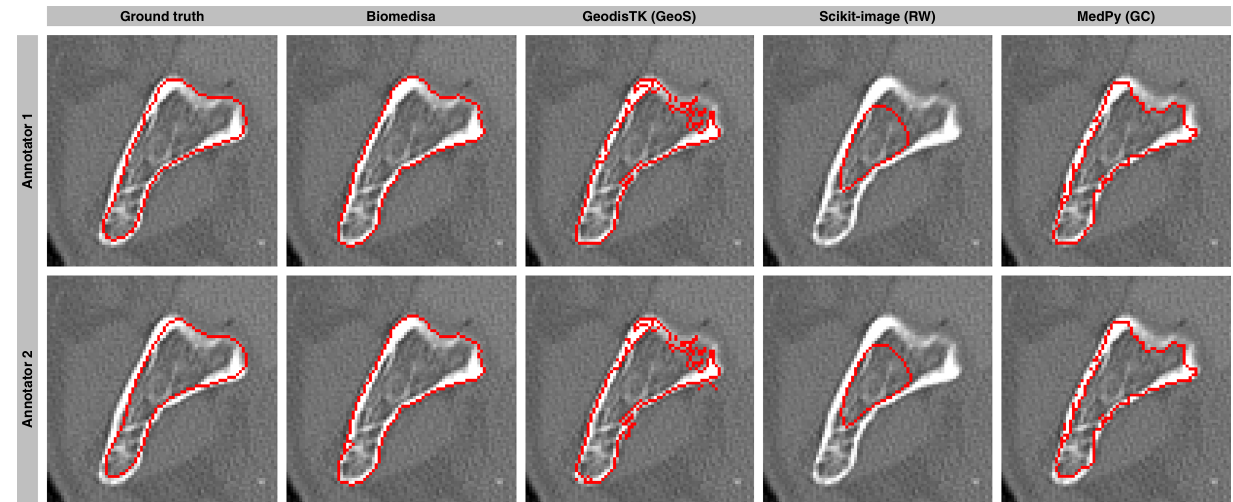
Fig. 7 Visual comparison of robustness to input errors. Visual comparison of different segmentation methods for segmenting a human mandible based on fl awed and inconsistent ground truth data labeled by two annotators. For the con fi guration, the values of the default parameters were chosen. If no default values were given, the values were selected from the examples in the documentation. Here, every 20th slice of the manual segmentation was used as initialization. The images show the segmentation result between two pre-segmented